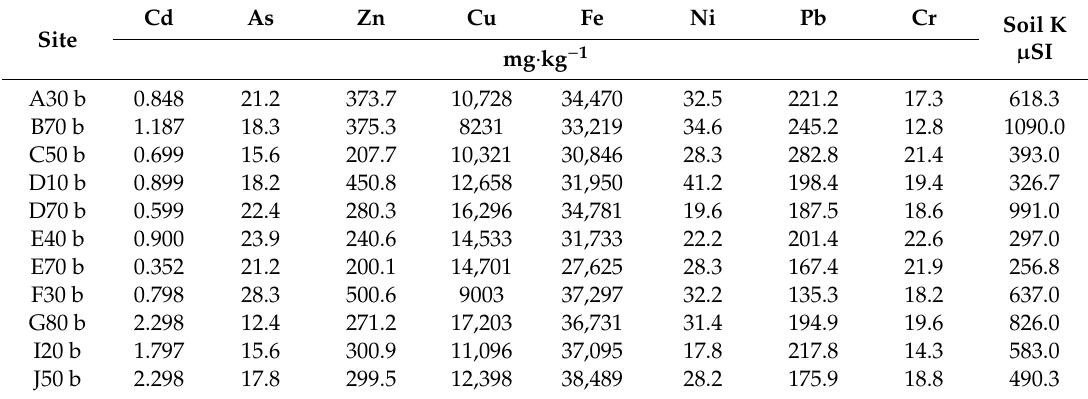
Table 4. Results of chemical analyses for the second stratum at a 10–20 cm depth.